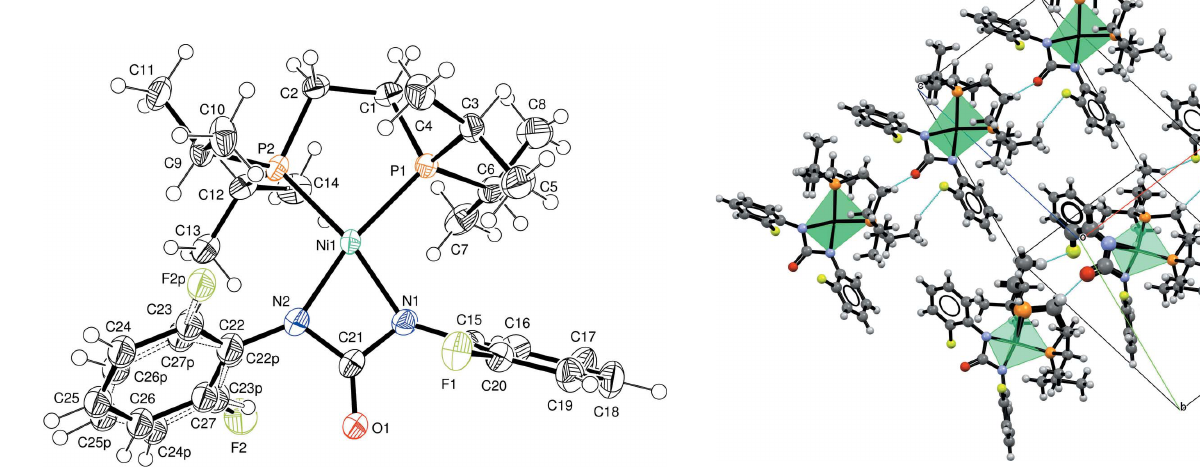
Figure 2 Crystal packing of [Ni(oFPU)(dippe)], showing the strongest C—H (cid:2)(cid:2)(cid:2) O and C—H (cid:2)(cid:2)(cid:2) F contacts as dashed lines. For clarity, only the major component of the disordered fluorophenyl ring (F2/C22–C27) is shown.